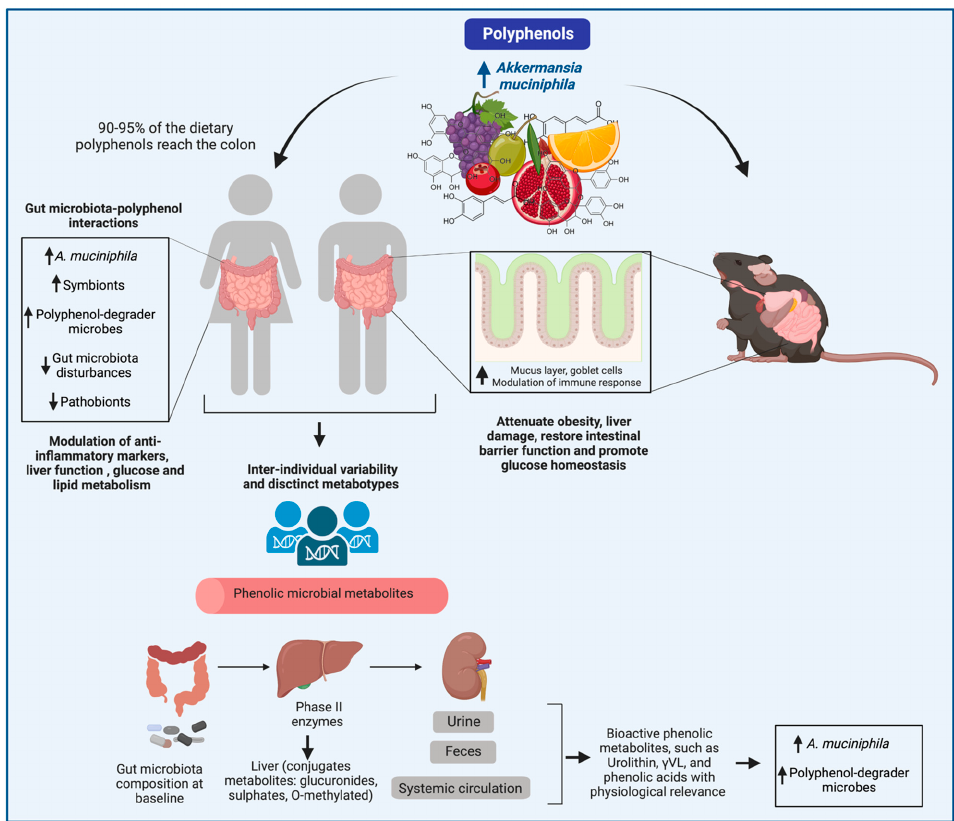
Figure 3. Schematic illustration of the modulatory effects of polyphenols on the gut microbiota, especially on A. muciniphila in humans and animals. A vast proportion of dietary polyphenols reach the colon, interacting with the gut microbiota. Polyphenols reduce gut microbiota disturbances and promote the relative abundance of A. muciniphila in humans and rodents. These changes are associated with improved metabolic phenotypes in the host. Interindividual variability in humans influences the effects of polyphenols on the gut microbiota and the production of bioactive metabolites, such as phenyl- γ -valerolactones ( γ VL), urolithins, and phenolic acids. Mechanistic insights into animal models sustain the role of polyphenols in signaling anti-inflammatory immune markers, increasing mucin-secreting goblet cells, and restoring intestinal barrier function. The graph was created with BioRender.